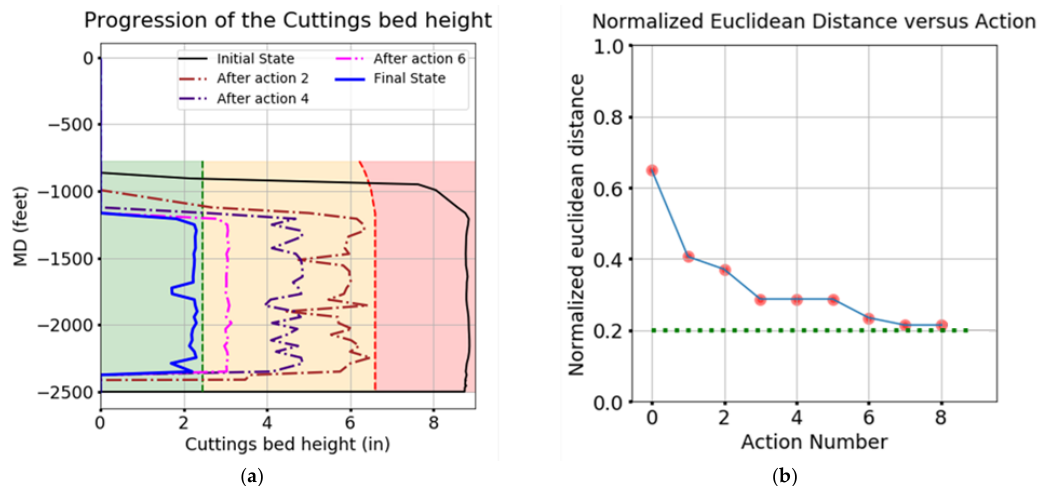
Figure 24. ( a ) Progression of the cuttings bed ( b ) Progression of the normalized Euclidean distance (blue line) of the system states for 𝑎 𝑠𝑒𝑞2 to an acceptable goal state (shown by the green dotted line, here taken to be a state at a normalized Euclidean distance of 0.2). Although, the final state representations for both the plans ( 𝑎 𝑠𝑒𝑞1 and 𝑎 𝑠𝑒𝑞2 ) are the same, the average 𝑉 value calculated for 𝑎 𝑠𝑒𝑞2 is 0.79, which is lower than for 𝑎 𝑠𝑒𝑞1 . The progres- sion of rewards for the sequence 𝑎 𝑠𝑒𝑞2 is shown in Figure 25. Figure 25. Progression of the rewards associated with 𝑎 𝑠𝑒𝑞2 .